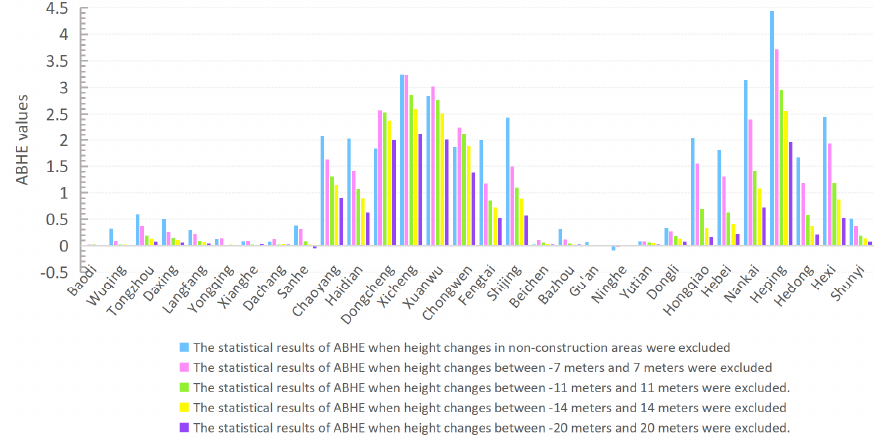
Figure 10. Comparison of building expansion between counties of Beijing–Tianjin–Hebei.